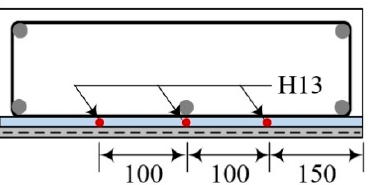
Figure 19. Additional tensile reinforcement (13 mm-bar) details (RS-2 series specimens).